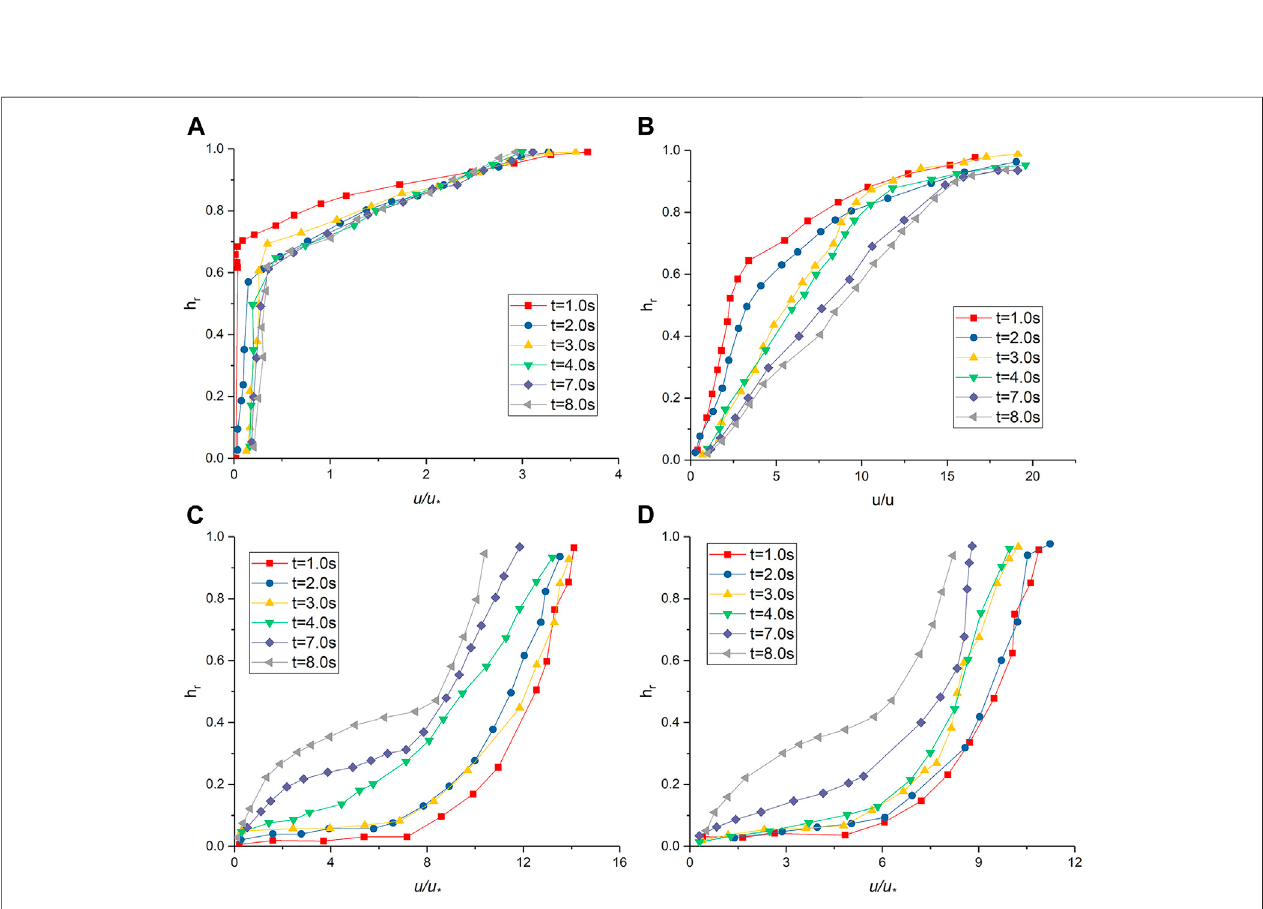
FIGURE 6 | Streamwise velocity pro fi le of fl uid, water erosion: (A) CS1; (B) CS2; (C) CS3; (D) CS4.